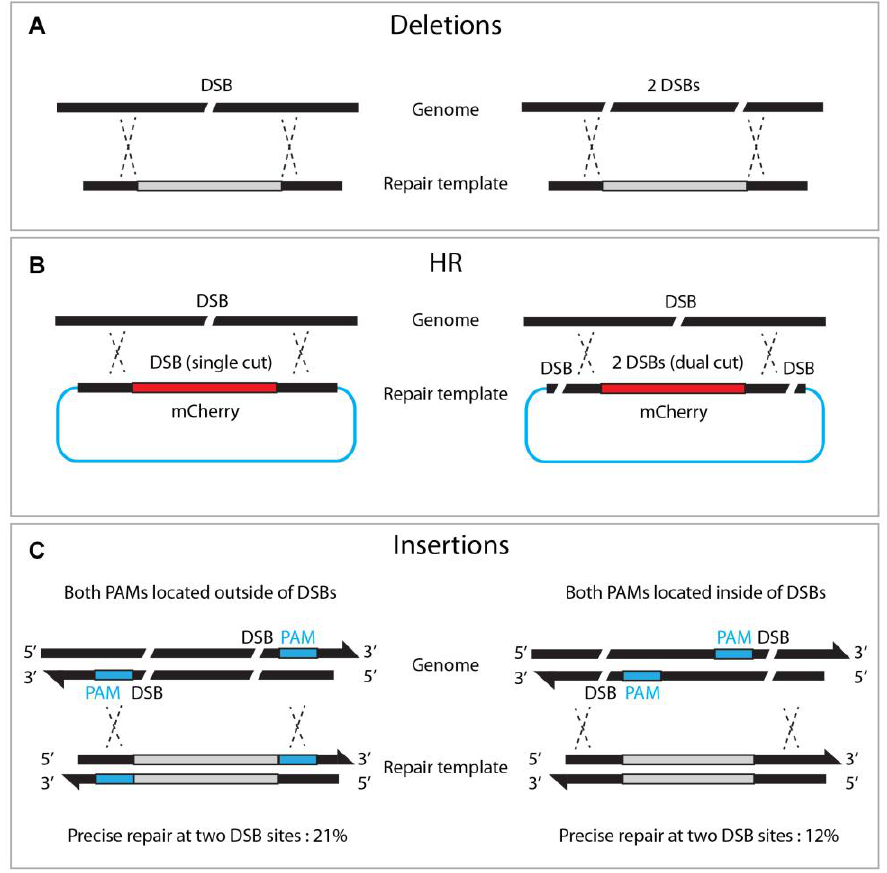
Figure 6. Dual DSBs enhance deletions, homologous recombination, and insertions. ( A ) Single versus dual DSBs at targeted sites. ( B ) Dual DSBs (right) in the repair template enhances HR efficacy compared to single DSB (left). ( C ) Locating both PAMs outward of the DSB sites enhances insertion frequency.